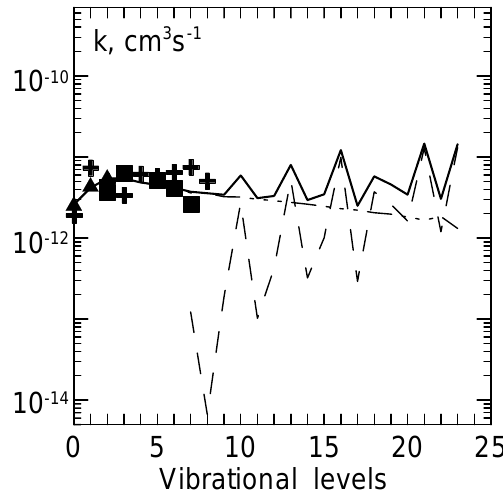
Fig. 7. The calculated quenching rate coefficients of N 2 (W 3 1 u , Fig. 9. The calculated quenching rate coefficients of N 2 (A 3 6 + u , v =0–18)+N 2 – solid line. Dashed line and dash and three dotted line v =0–23)+O 2 (solid line) are compared with experimental data of Fig.7. Fig.9. are the contributions of intramolecular and intermolecular electron Dreyer et al. (1974) (crosses), Thomas and Kaufman (1985) (trian- energy transfer processes, respectively. gles), De Benedictis and Dilecce (1997) (squares). Dashed line and dash and three dotted line are the contributions of intramolecular and intermolecular electron energy transfer processes,